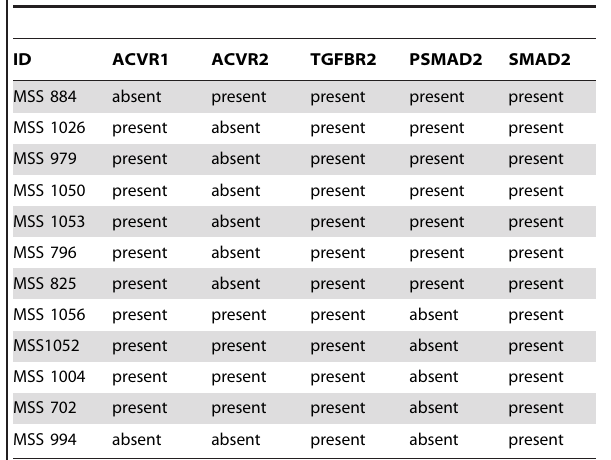
Table 1. Composition of protein expression of activin signaling proteins in colon cancers with loss of expression in at least one pathway member.